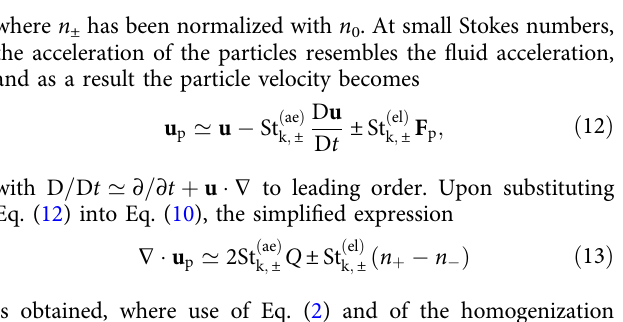
Fig. 2g indicate a high probability of encountering other